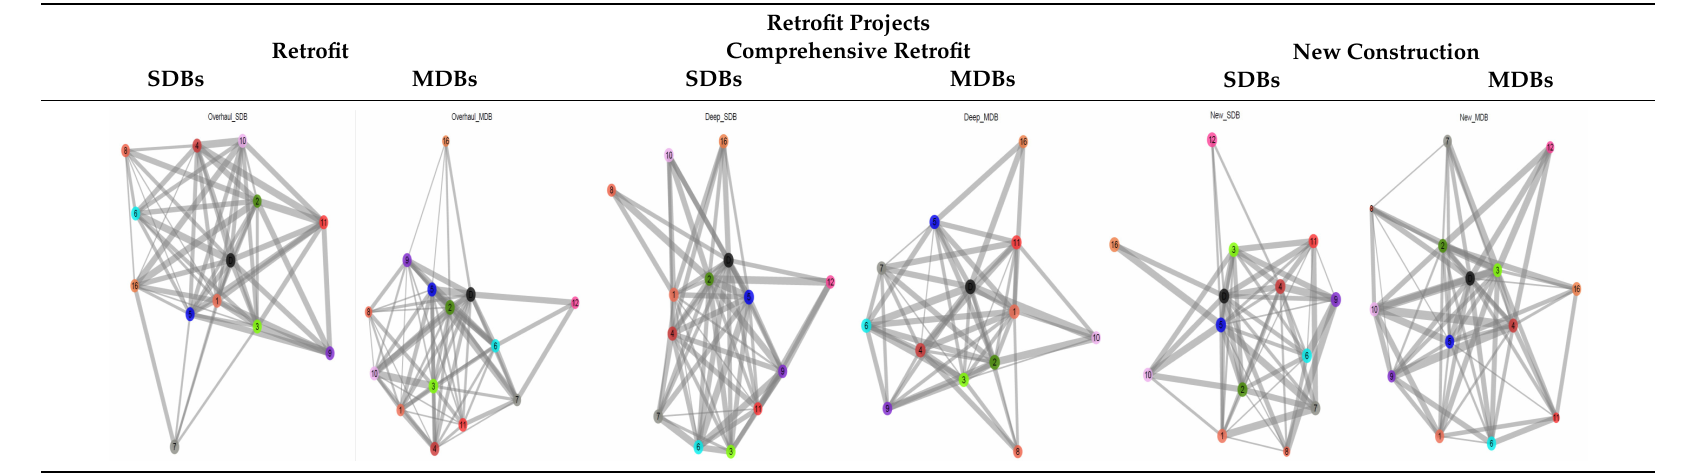
Table 7. Stakeholder level of power and interaction in the technology selection, classified according to building typologies and project types in Poland